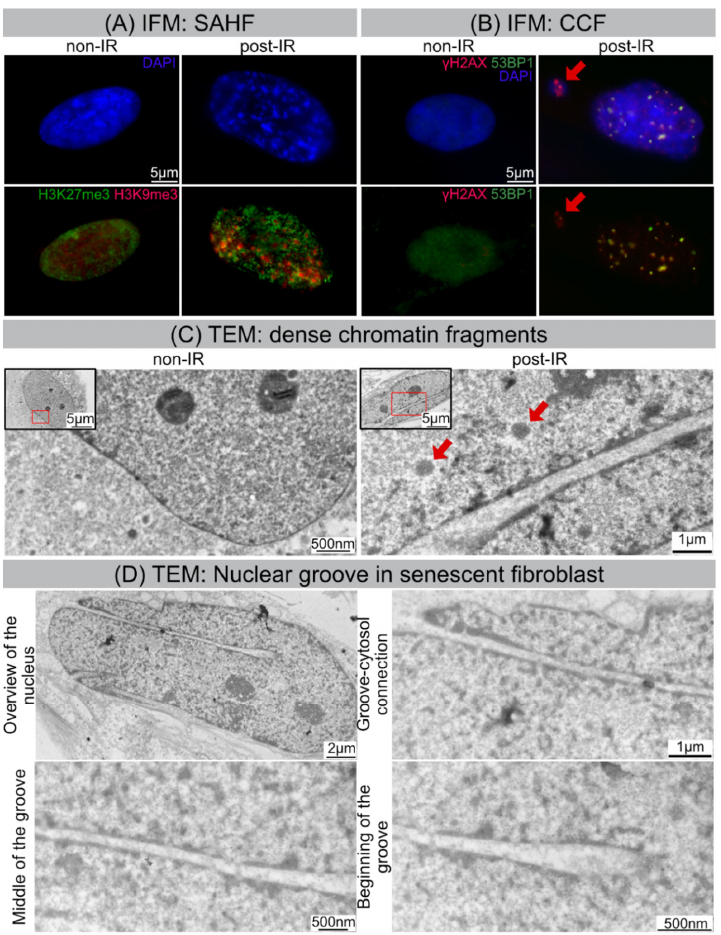
Figure 3. IR ‐ induced morphological changes in WI ‐ 38 fibroblasts . ( A ) Visualization of SAHF formation by IFM. ( B ) Visualization of CCF formation by IFM. ( C ) Visualization of dense chromatin fragments (marked by red arrows) by TEM. ( D ) Visualization of nuclear groove in senescent fibroblast by TEM. High ‐ resolution TEM was used for direct imaging the nuclear ultrastructure of se ‐ nescent nuclei at nanometer resolution. While non ‐ irradiated fibroblasts have regular nu ‐ clei without any nuclear blebs and grooves, ≈ 70% of irradiated fibroblasts revealed grooved nuclei with invaginations of various depths and sizes. These irregular invagina ‐ tions (sometimes multiple fissures within one cell) were observed in different parts of se ‐ nescent nuclei and seemed to be formed by nuclear membranes. TEM has an unparalleled resolution in X and Y dimensions, but due to limited field views and absence of Z dimen ‐ sions, it can generate only fragmented 2D views of senescent cells. Therefore, we used volume electron microscopy to identify and localize deep irregular ‐ formed invaginations in three ‐ dimensional space.